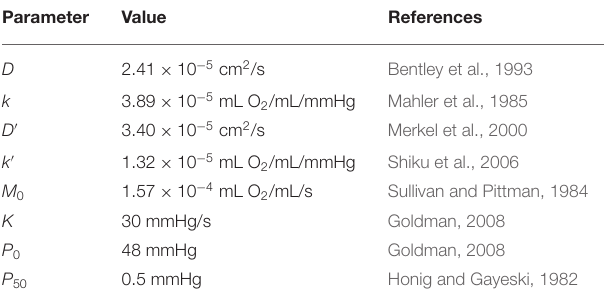
TABLE 1 | Parameters used in mathematical